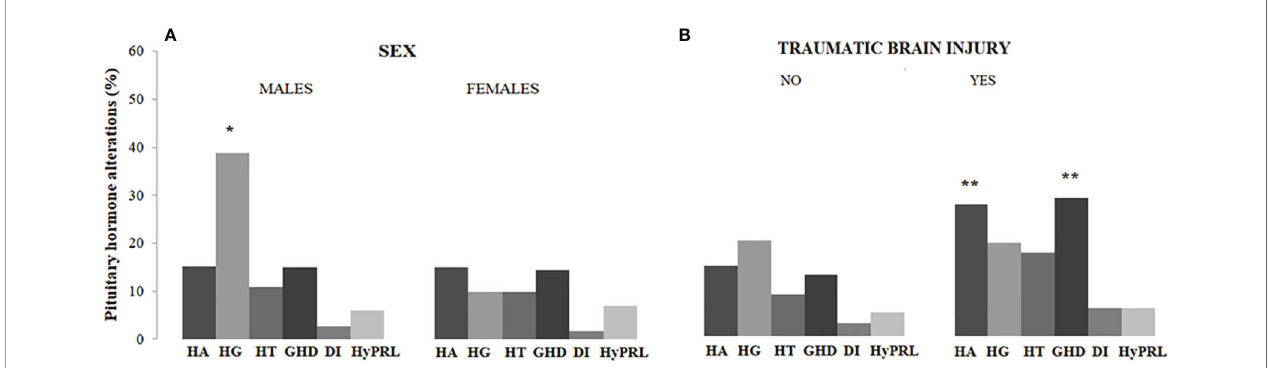
FIGURE 1 | Prevalence of pituitary hormone alterations in male and female patients with PES (A) and in patients with and without a history of traumatic brain injury (B) . HA, hypoadrenalism; HG, hypogonadism; HT, hypothyroidism; GHD growth hormone de fi ciency; DI, diabetes insipidus; HyPRL, hyperprolactinemia; * and **, statistically signi